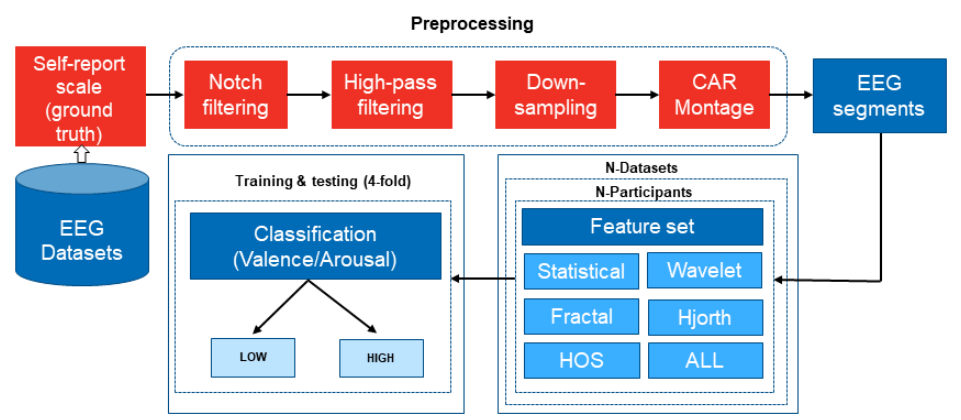
Figure 1. An overview of the proposed machine learning framework for emotion recognition based on EEG